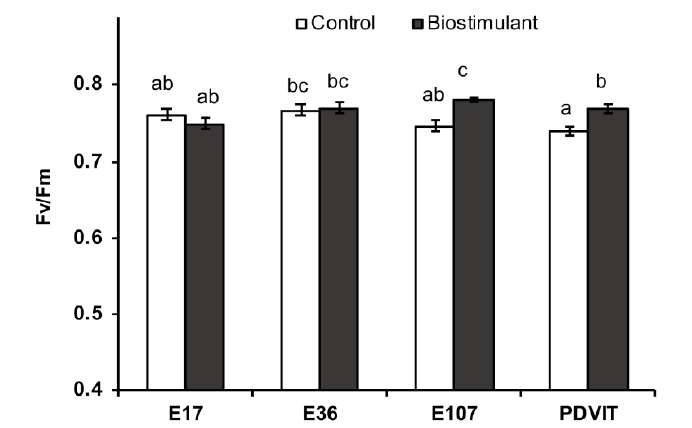
Figure 2. Maximal photochemical efficiency (F v /F m ) in leaves of four tomato genotypes. Data are mean ± SE (n = 5). Different letters indicate significant differences based on Tukey-HSD test ( p ≤ 0.05 ).